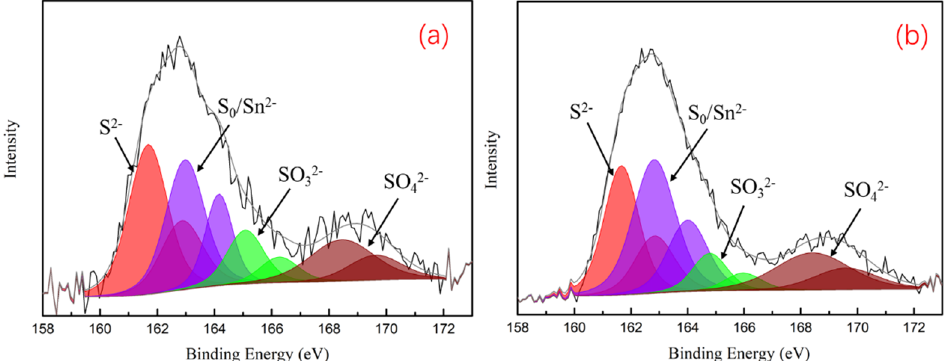
Figure 11. S 2p XPS spectra of ( a ) malachite treated with Na 2 S, ( b ) malachite treated with LA and Na 2 S ( c (LA) = 6.0 × 10 − 5 mol/L; c (Na 2 S) = 3.0 × 10 − 3 mol/L; pH = 9.6).